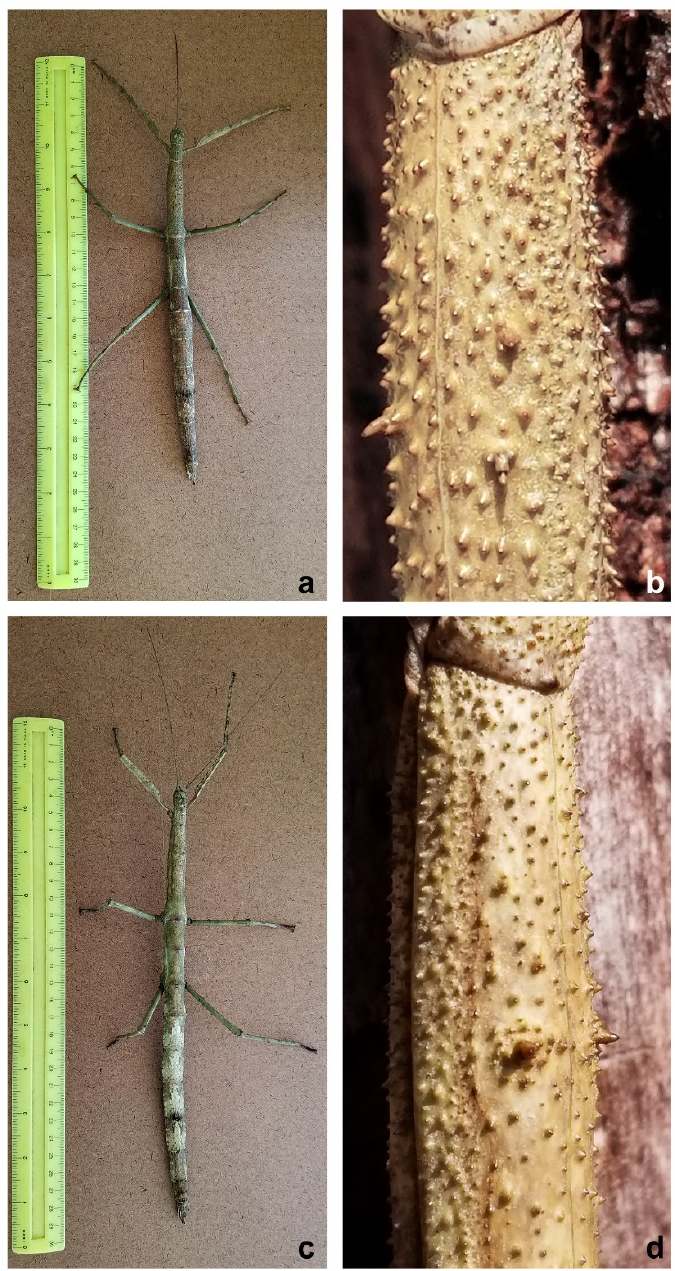
Figure 2. ( a ) General aspect of Cladomorphus petropolisensis ; ( b ) detail of the tegument of the mesonotum showing three higher spines; ( c ) general aspect of Cladomorphus phyllinus ; ( d ) detail of the mesonotum showing two higher spines.